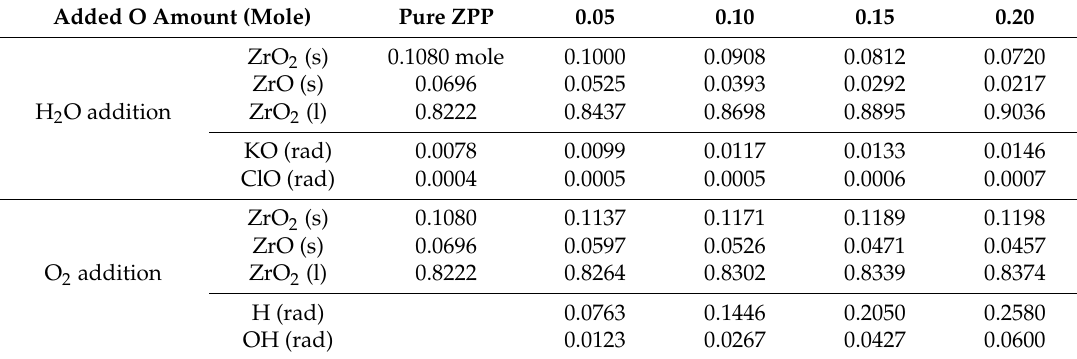
Figure 3. Flame temperature decrease of ZPP correlated with respect to the amount of oxygen sources (H 2 O or O 2 ) added. Table 2. Compositional changes of ZrO x species based on equilibrium calculations at the flame temperature at specific H 2 O and O 2 addition. The initial composition for equilibrium calculation is 1 mol of Zr, 0.05 mole of K and Cl, and 2 moles of O plus added moles of O, and the temperature and pressure for equilibrium calculation are the calculated flame temperatures shown in Figures 1 and 3, respectively.